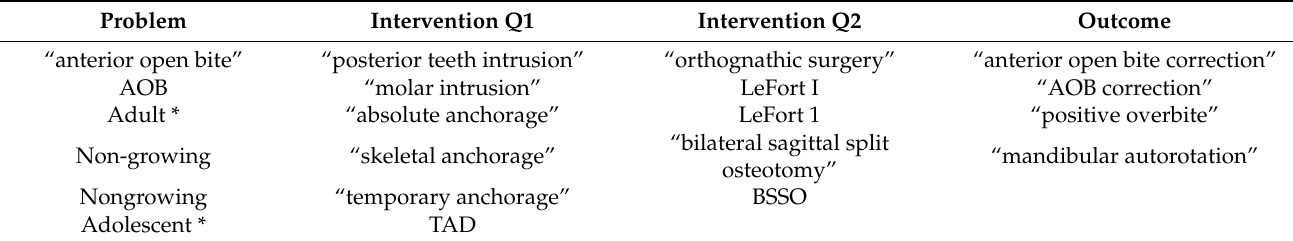
Table 1. Search terms used to extract suitable articles related to the topic of the